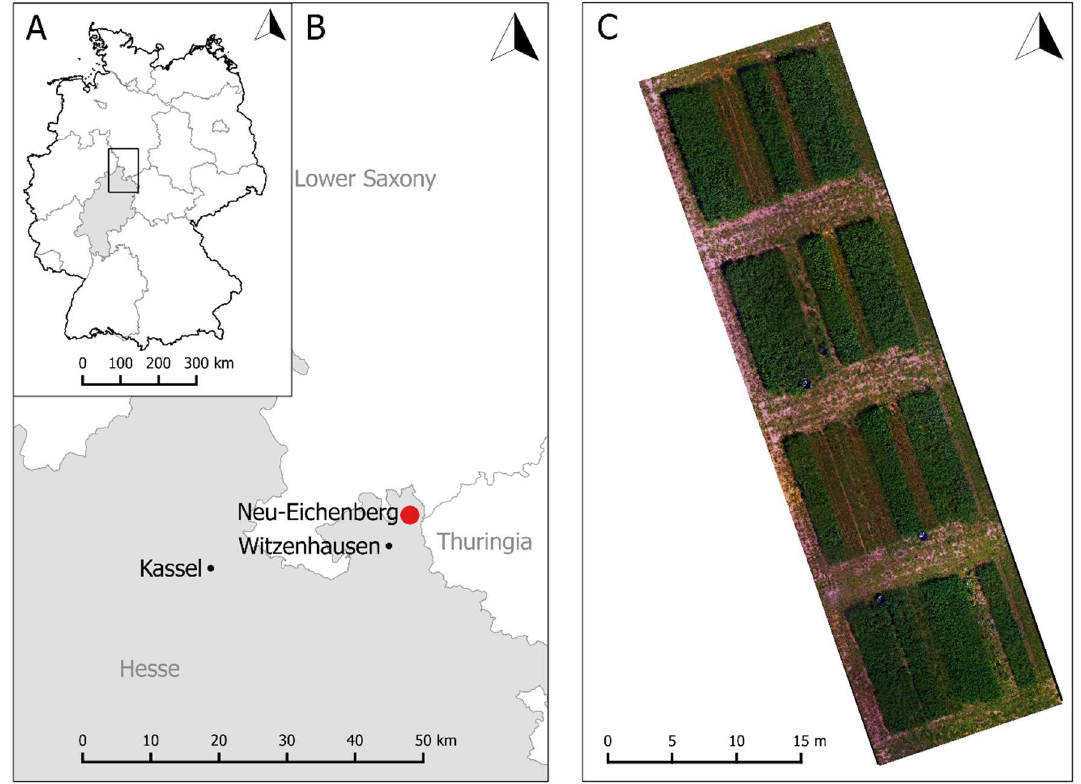
Figure 1. ( A ) Germany’s political map showing the location of Hesse; ( B ) North-Hesse’s political map showing the location of the experimental site in Neu-Eichenberg; ( C ) Orthomosaic of the experimental field showing the different plots on 7 August 2017, at the time of the third cut.